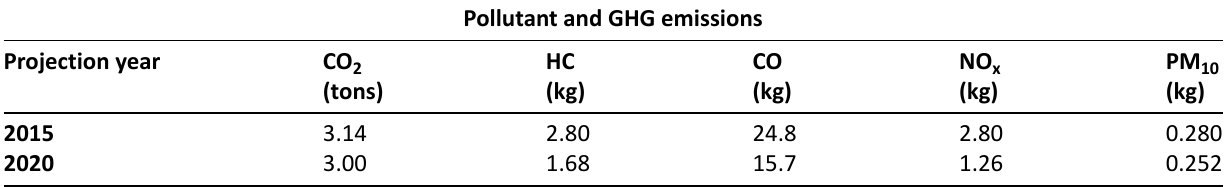
Table 6. Average pollutant and GHG emissions projected for the vehicles in the study in 2015 and